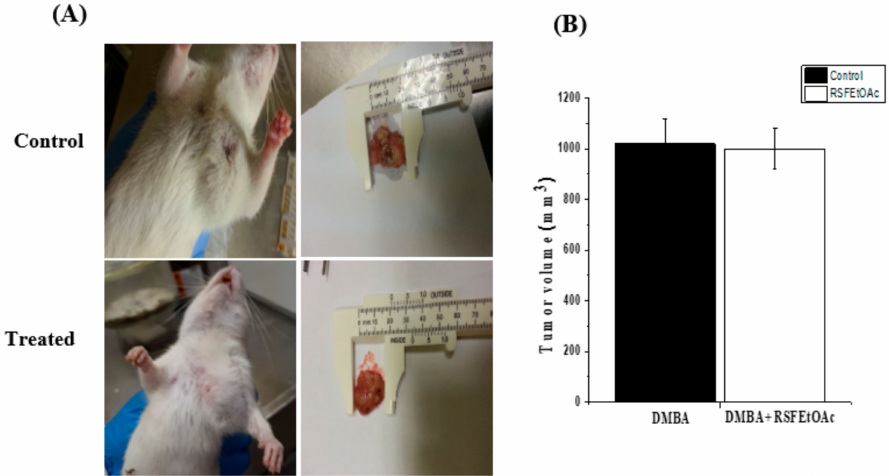
Figure 7. Breast cancer induced in Wistar albino rats ( Rattus norvegicus ) by subcutaneous injection of 9,10-dimethylbenz [a] anthracene (DMBA). ( A ) Tumor images in control (DMBA group) and after injection with RSF EtOAc extract and the size of excised tumors formed. ( B ) tumor volume in control and treated groups was calculated as described in materials and methods.